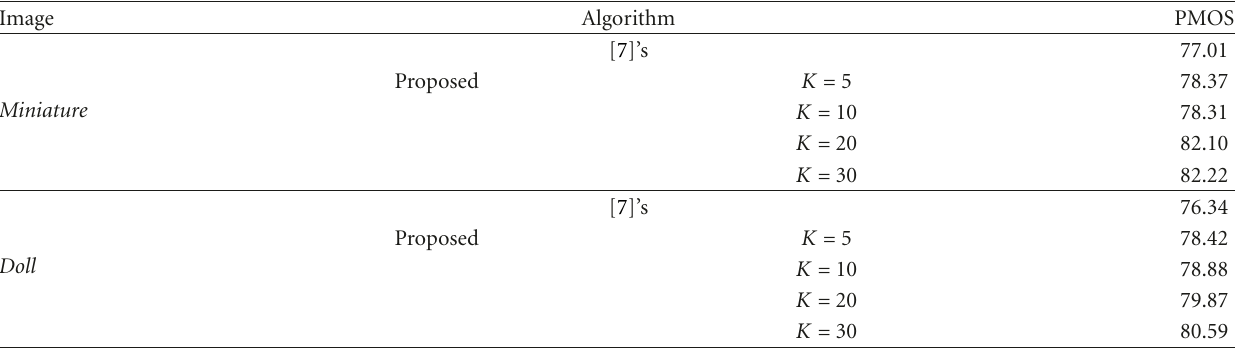
Table 2: Quantitative evaluation of deblurred results in real blurred